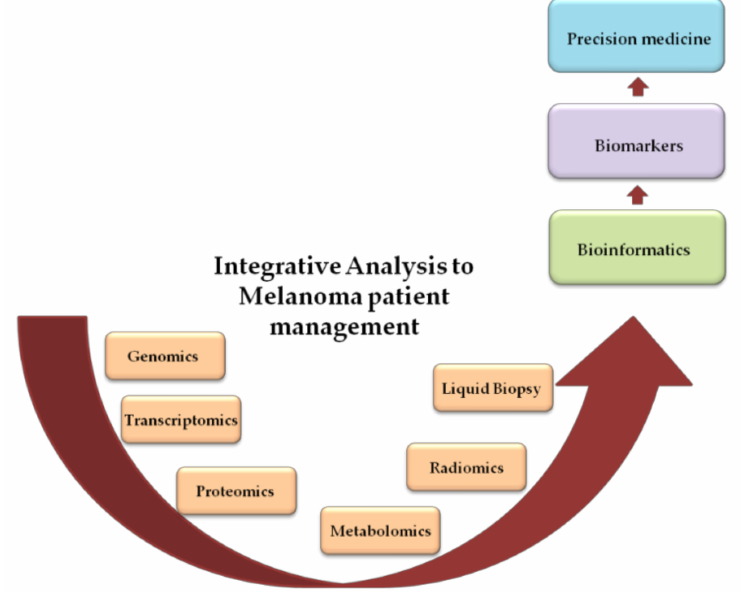
Figure 1. Schematic representation of data flow from basic to clinic